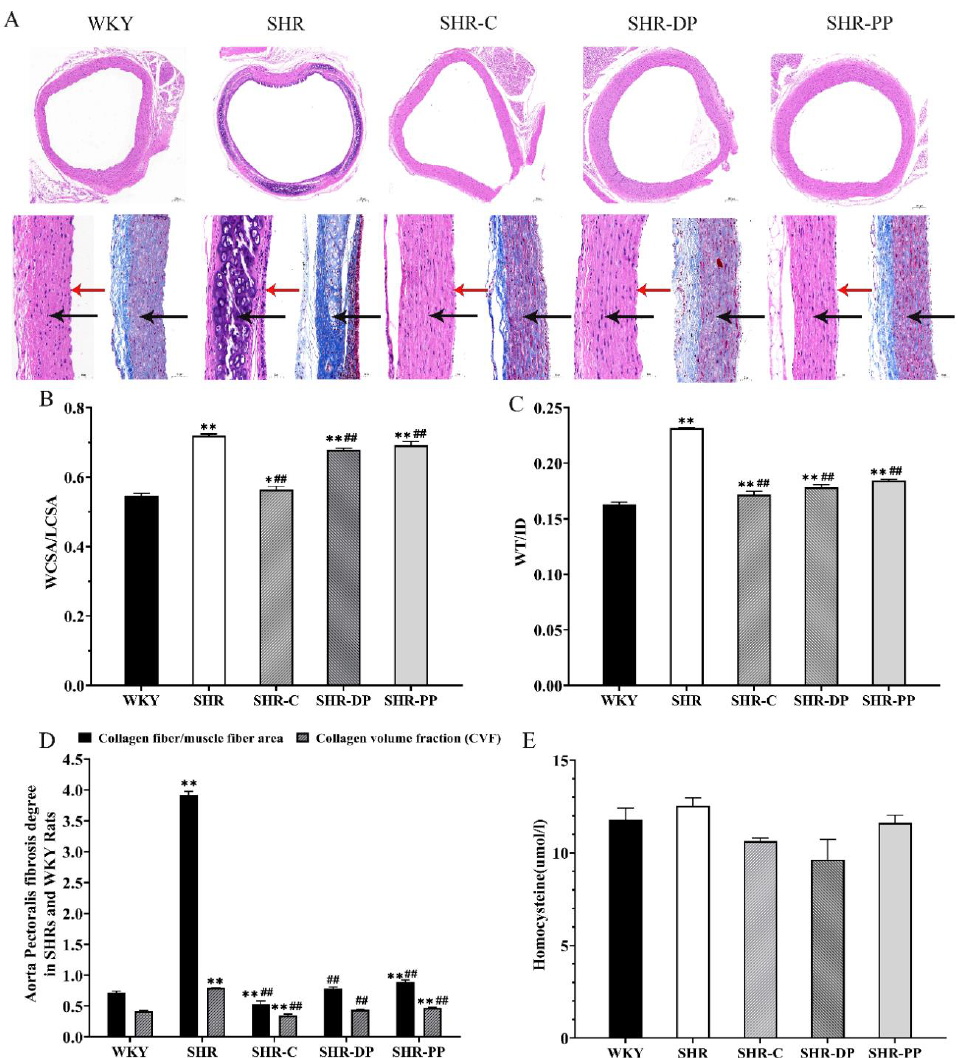
Figure 3. The influence of thoracic aortic vascular remodeling, fibrosis and the concentration of Hcy in the serum of rats in each group after pea peptide and two-peptide composite intervention. ( A ) The representative micrographs of rat thoracic aorta with the HE staining (4.5× and 30×) and Masson staining (20×), the tunica media is represented by a black arrow, endangium is represented by a red arrow; ( B , C ) Characterization parameters of vascular remodeling, WCSA/LCSA and WT/ID; ( D ) Degree of thoracic aorta fibrosis in rats of each group; ( E ) Serum concentration of Hcy. The data in the figure are expressed as mean ± SEM. * p < 0.05, ** p < 0.01, represents the difference from the WKY group, respectively; ## p < 0.01, represents the difference from the SHR group, respectively.